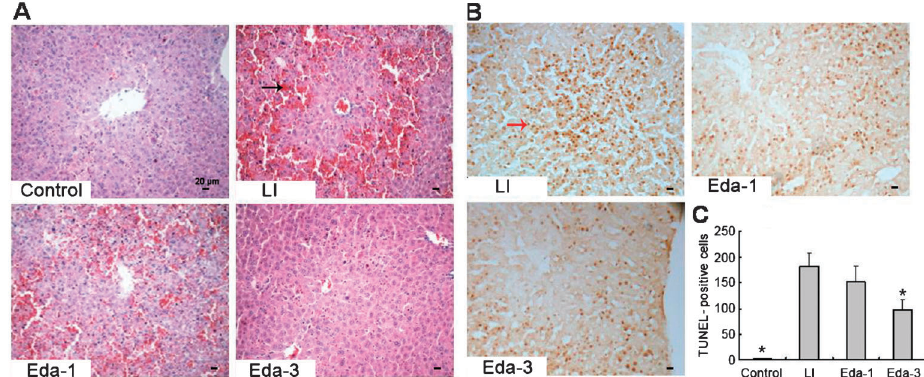
Figure 2. Histological examination and TUNEL staining. A , H&E staining of the livers after D-galactosamine and lipopolysaccharide (GalN/LPS) treatment. Representative images were captured from the 4 groups (scale bar: 20 m m). Sham group: normal lobular architecture and cell structure; LI group: GalN/LPS induced extensive hemorrhage (black arrow), massive hepatocellular necrosis and a moderate increase in inflammatory cells; Eda-1 and Eda-3 groups: edaravone at 1 and 3 mg/kg ameliorated GalN/LPS-induced liver